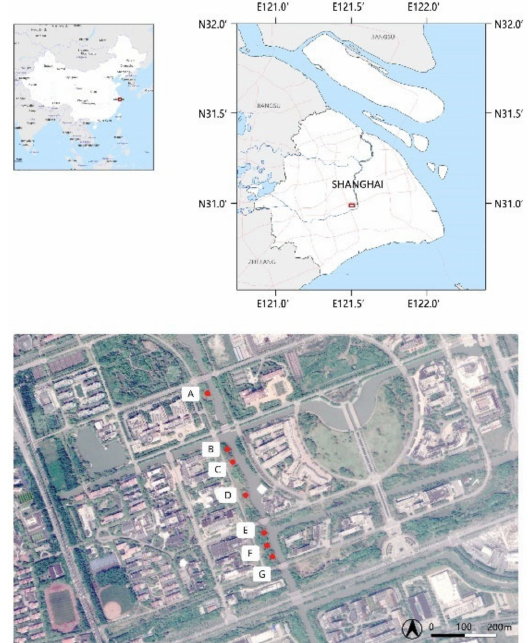
Figure 1. Location of 7 riparian experimental sites along Danshui River in Minhang District, Shanghai—C CO (A), C MO (B), C H (C), C CH (D), C UO (E), C MH (F) and C UH